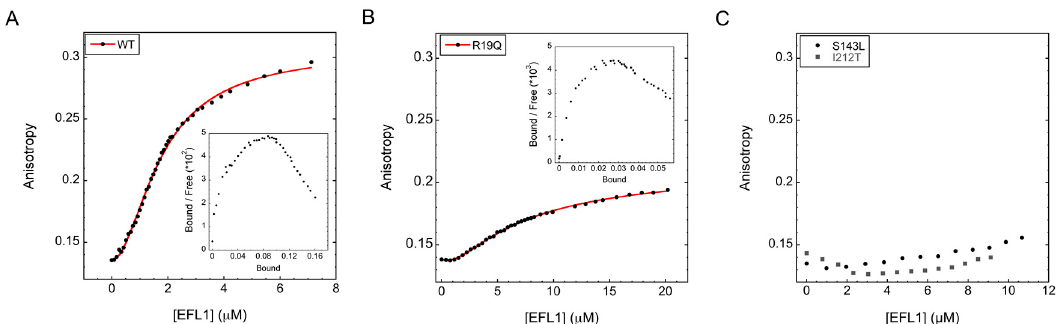
Figure 1 . Binding of human Elongation Factor Like-1 (EFL1) to representative Shwachman-Bodian- Diamond Syndrome protein (SBDS) missense disease variants, evaluated by fluorescence anisotropy. ( A ) SBDS wild type, ( B ) SBDS R19Q, ( C ) SBDS S143L and I212T. Continuous line represents the fit of the data to a two different binding sites model. Insets in (A) and (B) correspond to the Scatchard plots. Table 1 . Dissociation constants for the interaction between the human EFL1 and different SBDS domains and missense variants.